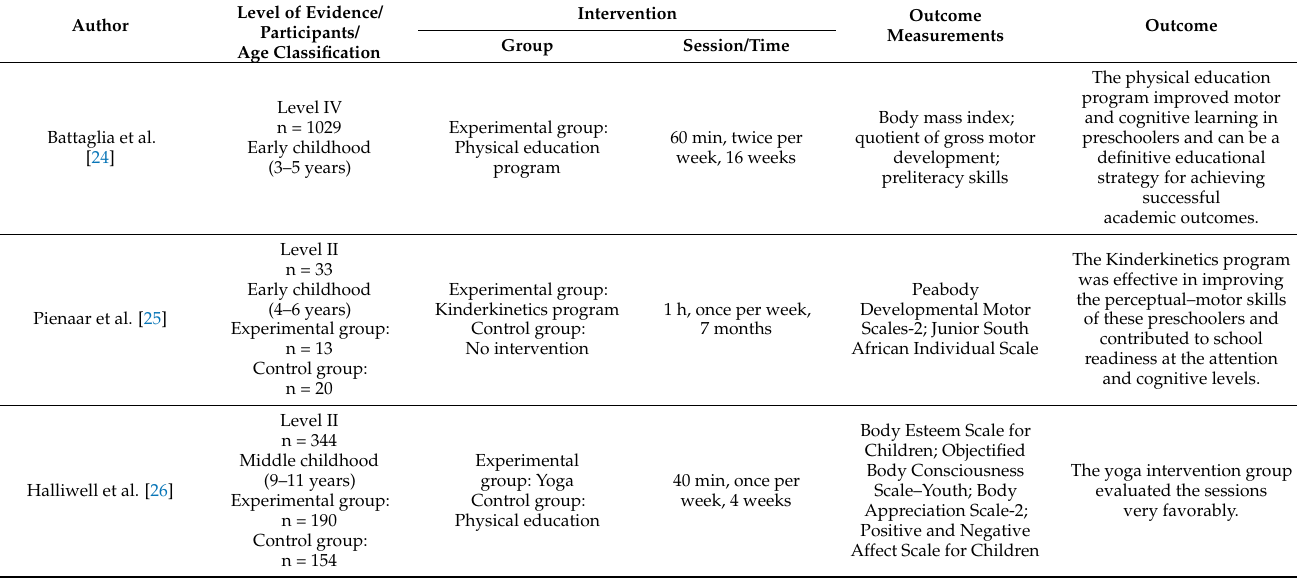
Table 3. Evidence Related to Body Awareness for Children (n =